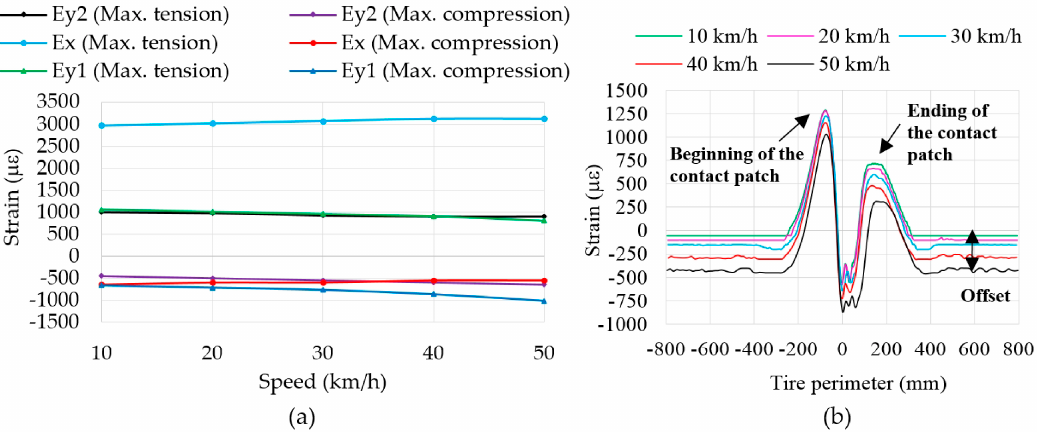
Figure 8. ( a ) Influence of speed in maximum strain values; ( b ) Comparison of curves at different speeds in ε y2 at 1 bar and 750 N.